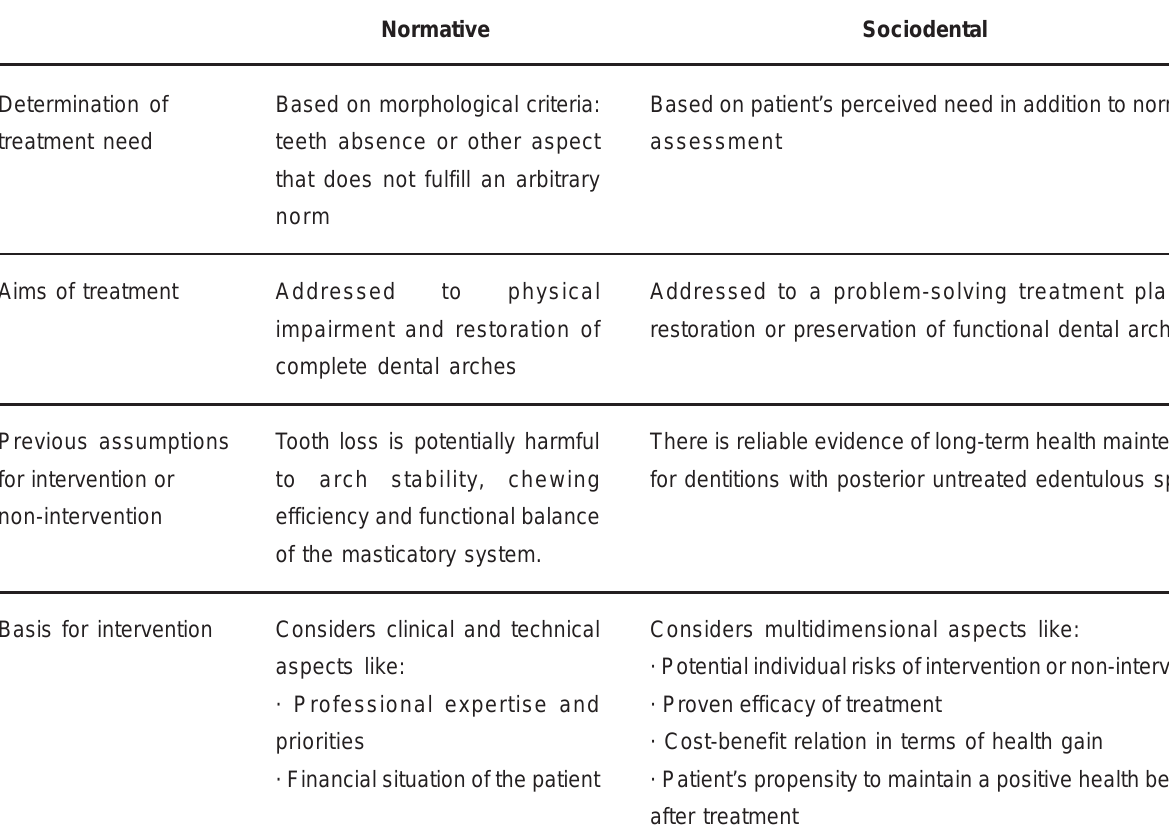
TABLE 1 - A normative (traditional) approach versus a sociodental approach in prosthetic treatment